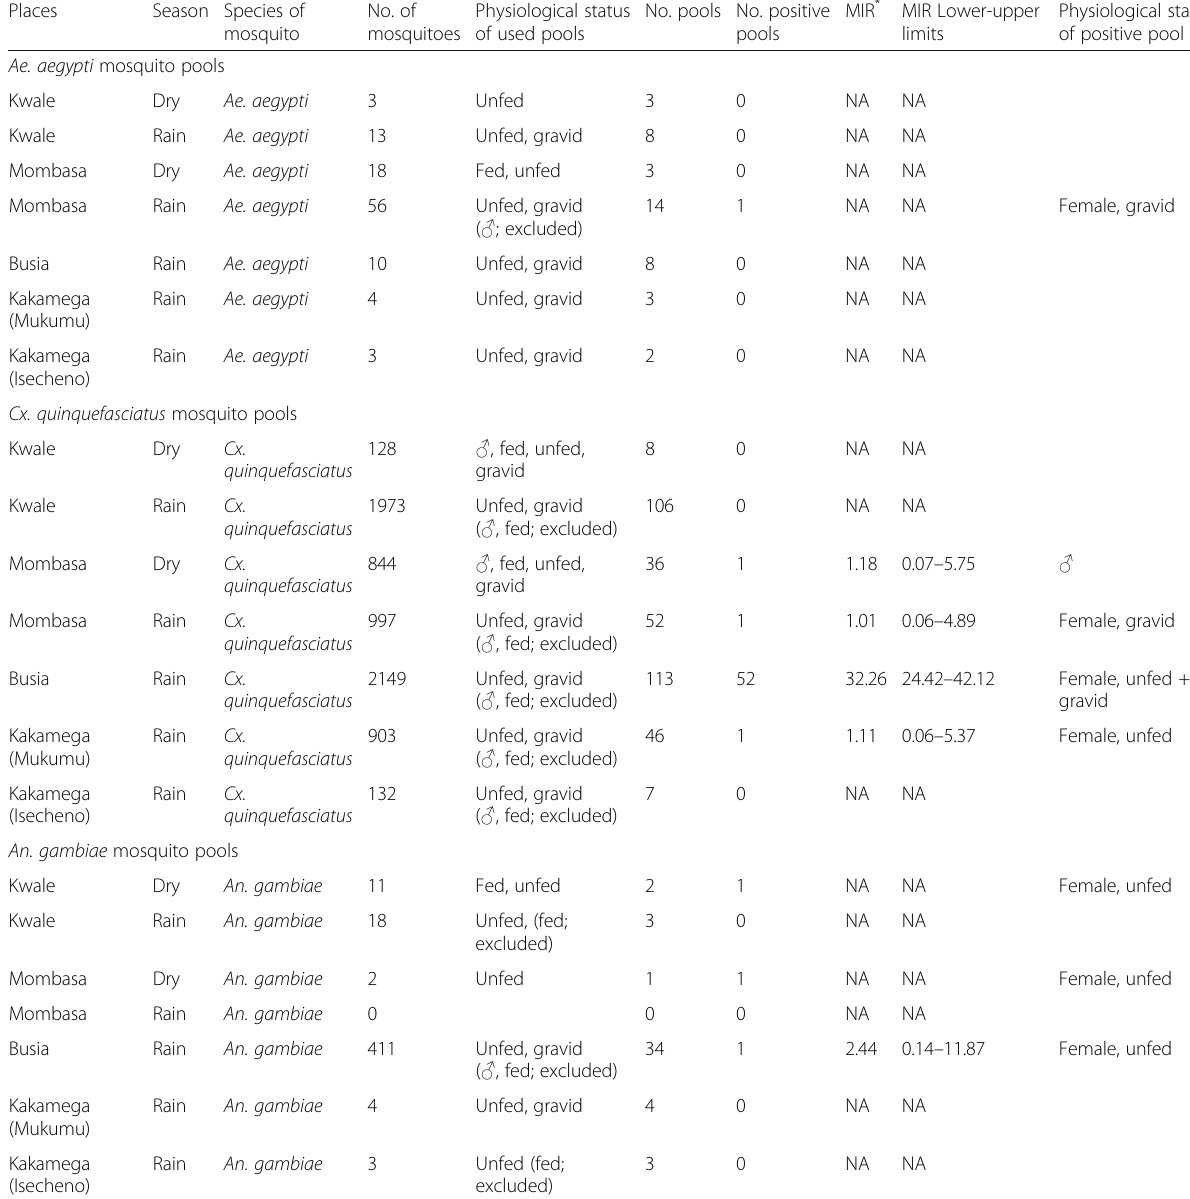
Table 4. Information of positive samples for insect specific arbovirus Places Season Species of